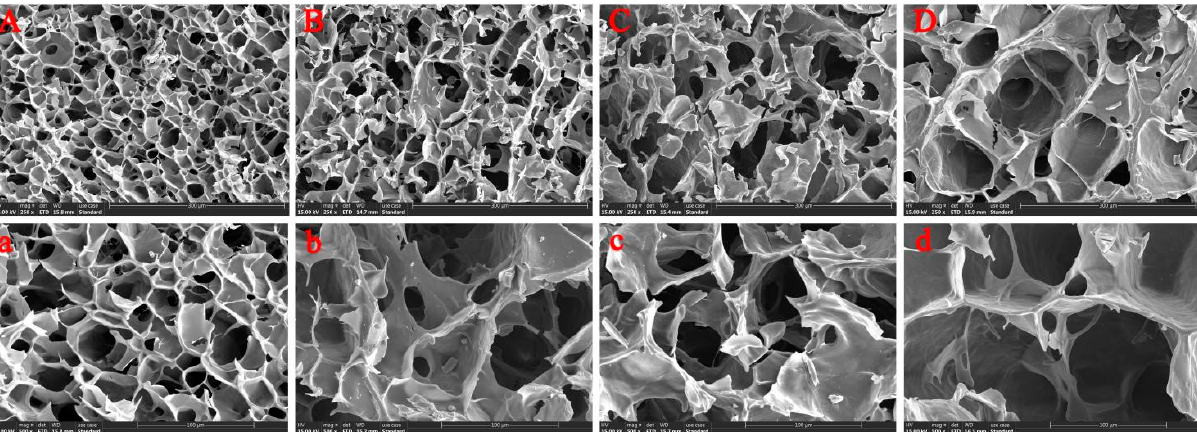
Figure 2. SEM images of wheat starch gel with different concentrations of LRE. ( A , a ) Control group. ( B , b ) 5% LRE group. ( C , c ) 10% LRE group. ( D , d ) 20% LRE group. (Capital letters represent the magnification of 250 times; lowercase letters represent the magnification of 500 times.) LRE: Ligustrum robustum (Rxob.) Blume extract.